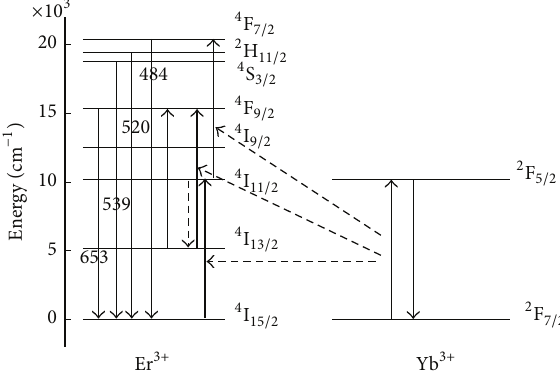
Figure 8: Schematic diagram illustrating the relative energy level of Er 3+ and Yb 3+ .